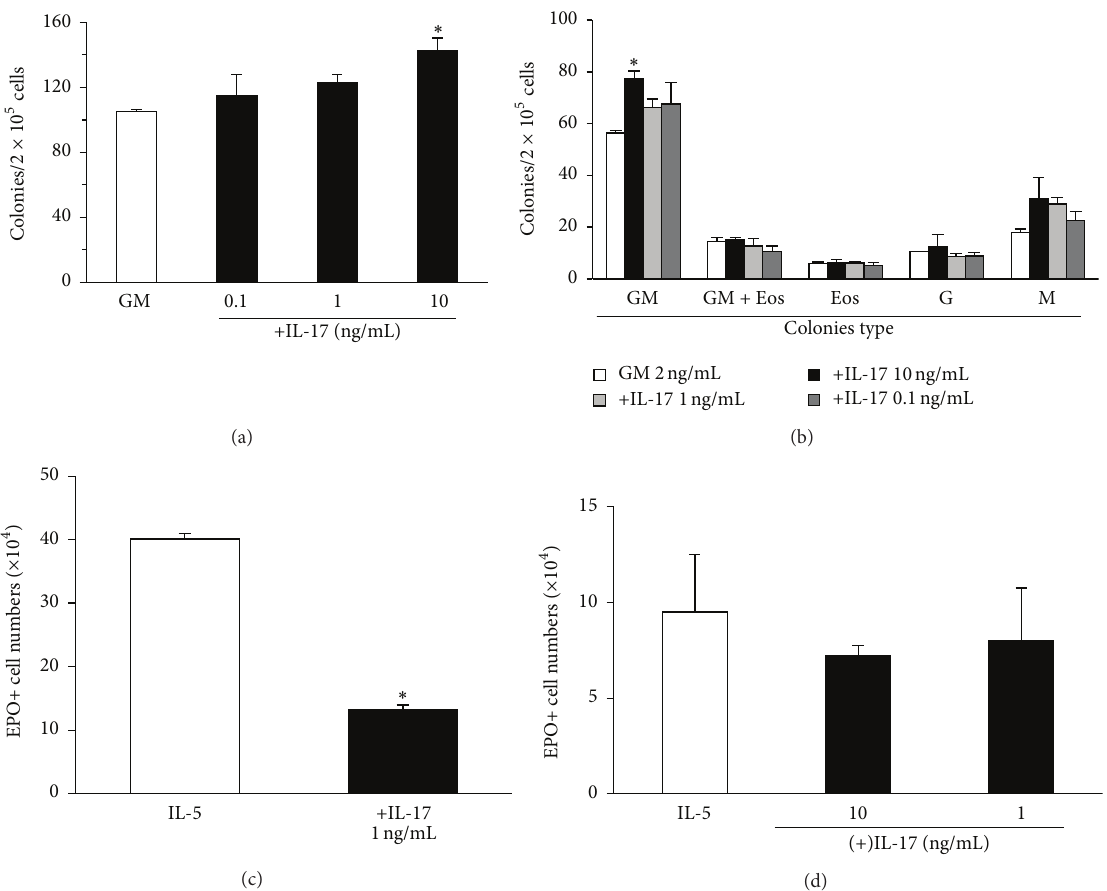
Figure 3: IL-17, effect on progenitor responses and requirement for IL-17RA. (a, b) Semisolid cultures were established for 7 days, from 2 × 10 5 bone-marrow cells of naive BALB/c mice, in the presence of GM-CSF (2ng/mL), alone or in association with IL-17A at the indicated concentrations. Total (a) and differential (b) colony counts were carried out under the inverted microscope, directly (a) or after staining dried agar layers for EPO and counterstaining by Harris’ Hematoxylin (b). Colony types in (b) are [36] pure granulocyte-macrophage (GM), mixed granulocyte-macrophage-eosinophil(GMEos),pureeosinophil(Eos),puregranulocyte(G),andpuremacrophage(M).GM-CSFalone,black bar. GM-CSF in association with IL-17A (0.1 to 1 ng/mL), white bars. (c) Liquid cultures were established as described by Gaspar-Elsas et al. [38], in a two-phase culture with progenitor expansion in Flt3L and SCF, followed by eosinophil differentiation for up to 10 days with GM-CSF, IL-3, and IL-5, in the absence (white bar) or presence (black bar) of IL-17A (1ng/mL). (d) Liquid cultures were established as in Figure 1(a), with bone-marrow from BALB/c mutants lacking IL-17RA. Data are mean ± SEM. ∗ 𝑃 < 0.05 . Significant differences relative to GM controls (a, b) or IL-5 controls (c, d). All groups, 𝑛 = 3